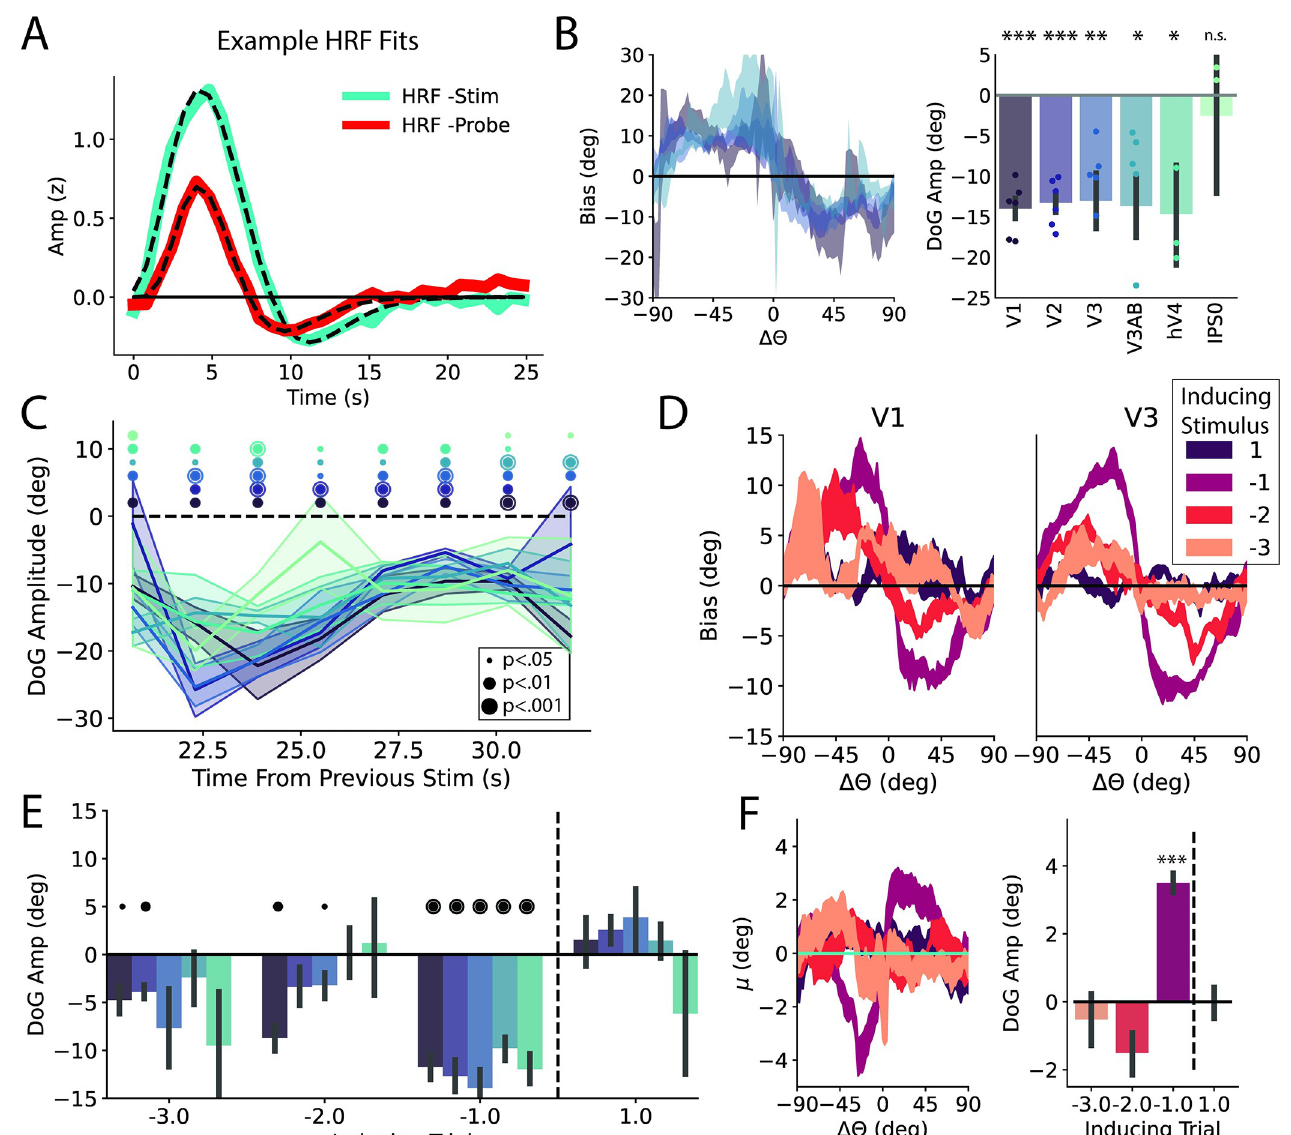
Fig 3. Influence of BOLD-specific biases on repulsive bias. (A) Average V1 HRF through deconvolution for stimulus and probe. Average best fit double gamma function overlaid in dotted lines. (B) (Left) Bias curves from decoder trained on response patterns from deconvolved double-gamma functions ( ± SEM across participants). Here excluding hV4 and IPS0 for clarity. (Right) Bias quantified with a DoG function across ROIs. (C) Bias across time including only trials with an ISI of at least 17.5 seconds. x-Axis reflects minimum time from previous stimulus. Repulsion significant in all ROIs at 32 seconds. (D) Bias as a function of various relative orientations for V1 and V3 ( ± SEM across participants). (E) Bias across early visual ROIs for N-1, N-2, and N-3. Color scheme same as C. N+1 control analysis to ensure effects not driven by some unknown structure in stimulus sequence. (F) Behavioral bias for various relative orientations. N-1 data same as data presented in Fig 2. � , p < 0.05, �� , p < 0.01, ��� , p < 0.001. Data and code supporting this figure found here: https://osf.io/e5xw8/?view_ only=e7c1da85aa684cc8830aec8d74afdcb4. DoG, Derivative of Gaussian; HRF, hemodynamic response function; ROI, region of